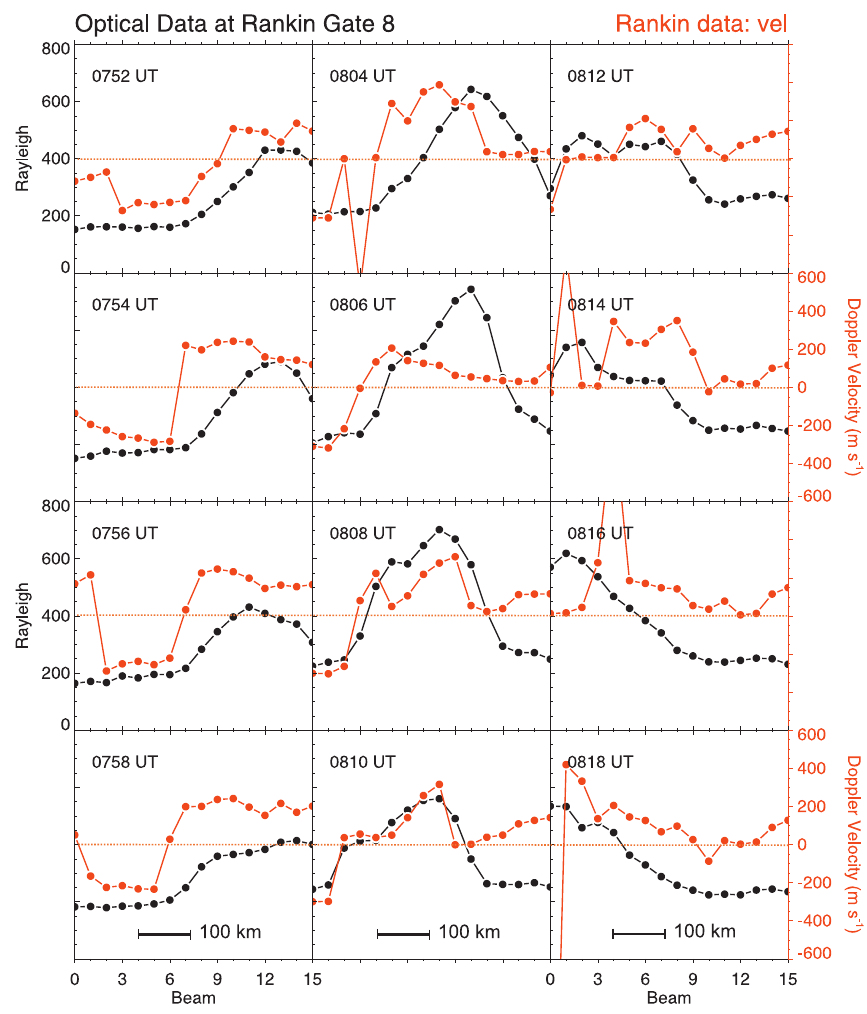
Fig. 7. RANK radar velocity in gate 8 (red) for a number of selected radar azimuthal scans between 07:52 and 08:20UT. Black line is the luminosity intensity in radar gate 8 for every beam position. A scale bar at the bottom panels is a 100-km distance in the azimuthal direction (along a circle) at the radar range of